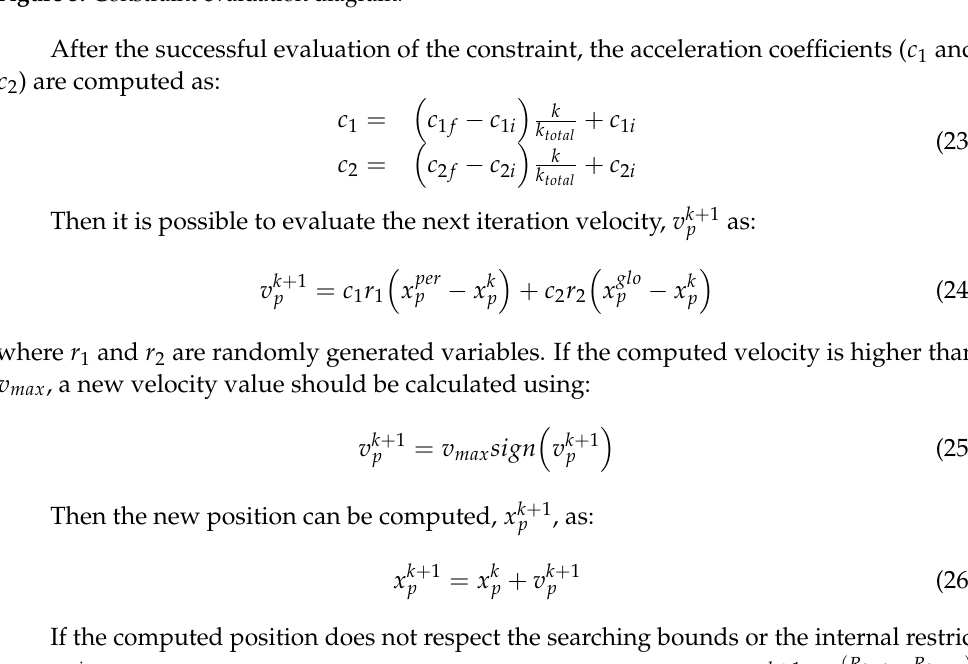
Figure 3. Constraint evaluation